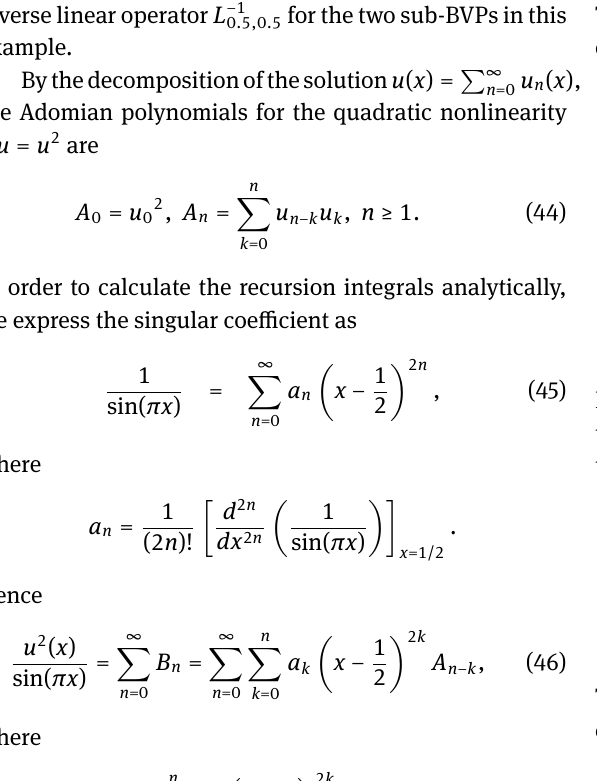
In the subinterval [0.5, 1], from Equation (29) we obtain the equivalent nonlinear Fredholm-Volterra integral